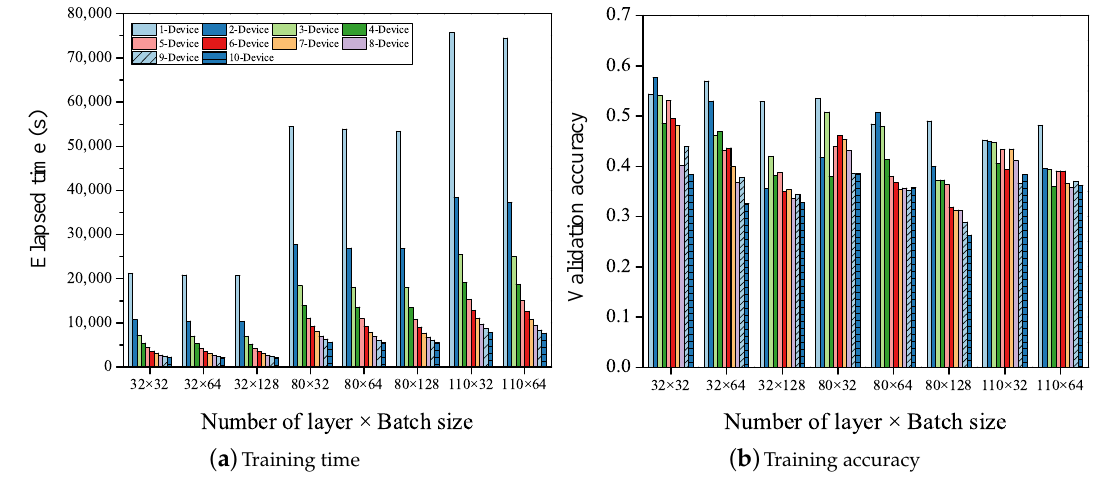
Figure 5. ResNet training time and accuracy by number of layers and batch size (1